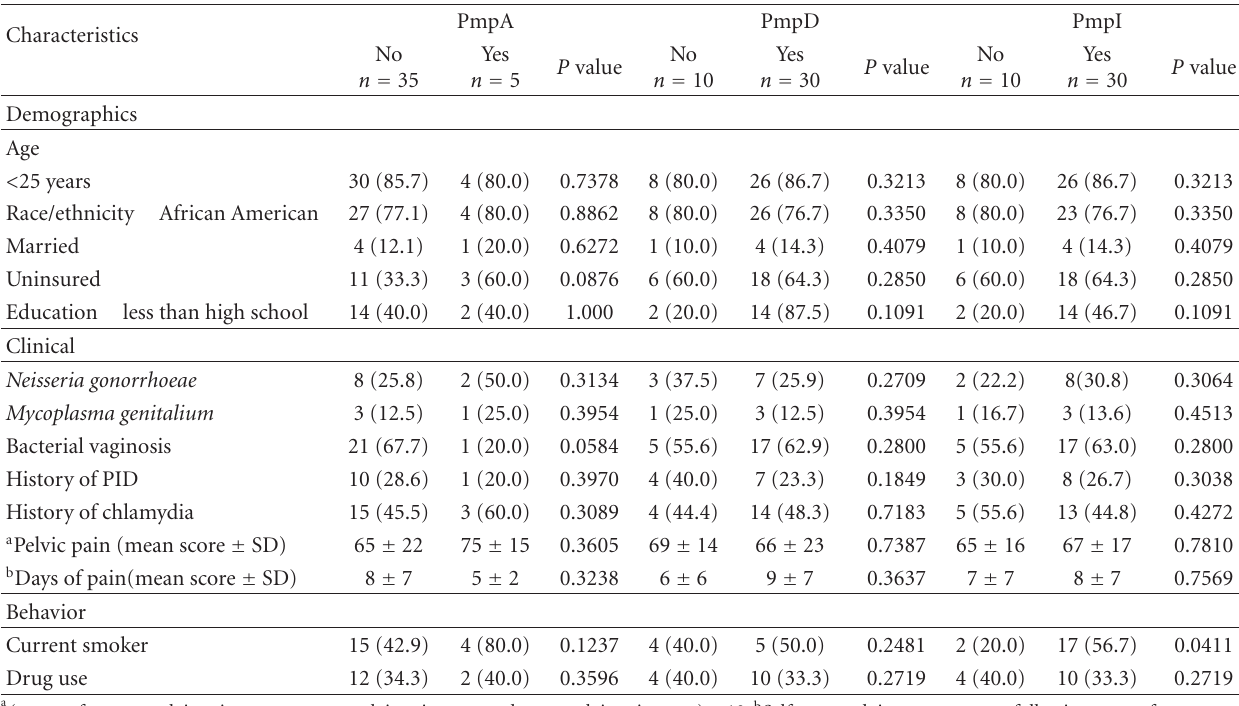
Table 1: Baseline characteristics of women by Pmp antibody